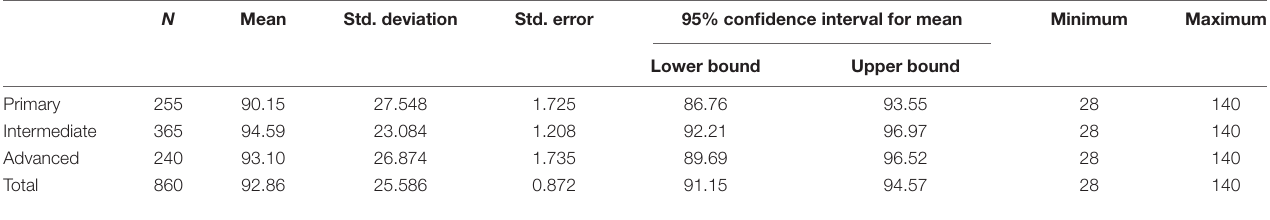
TABLE 9 | Descriptive analysis for English level. N Mean Std. deviation Std.